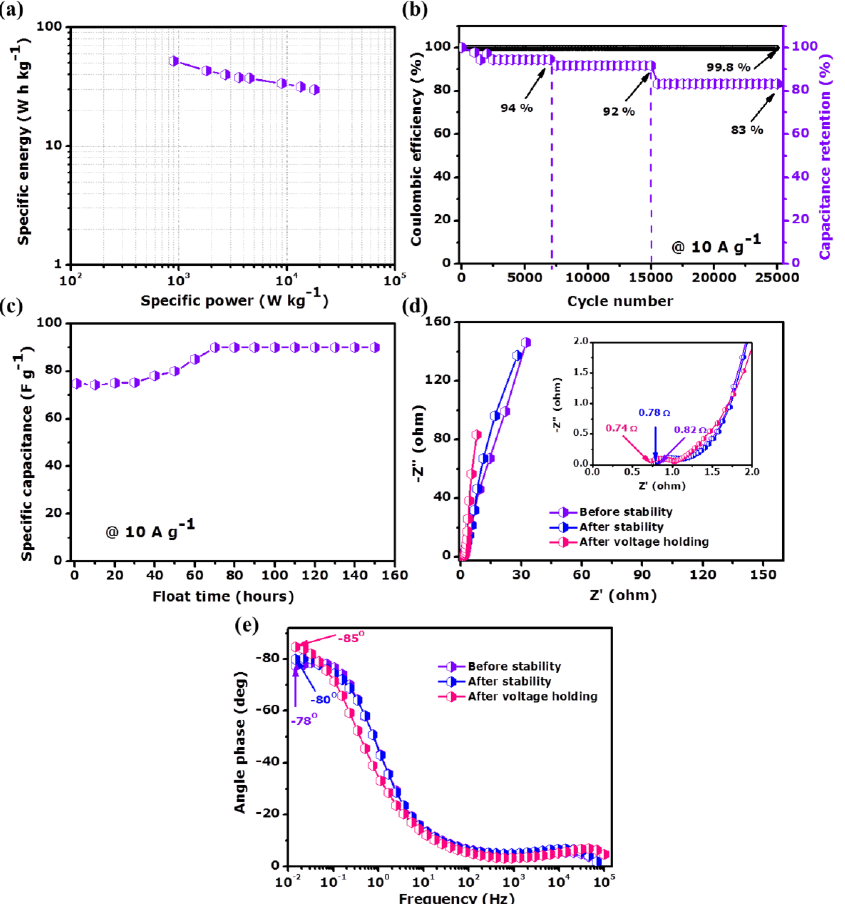
Figure 10. ( a ) Ragone plot, ( b ) cycling stability up to 25,000 cycles, ( c ) specific capacitance as function of voltage holding time up to 180 h, ( d ) Nyquist plots and ( e ) Bode plot of PAC/MoO 2 /Mo 2 C-1//PAC/MoO 2 /Mo 2 C-1 symmetric cell.